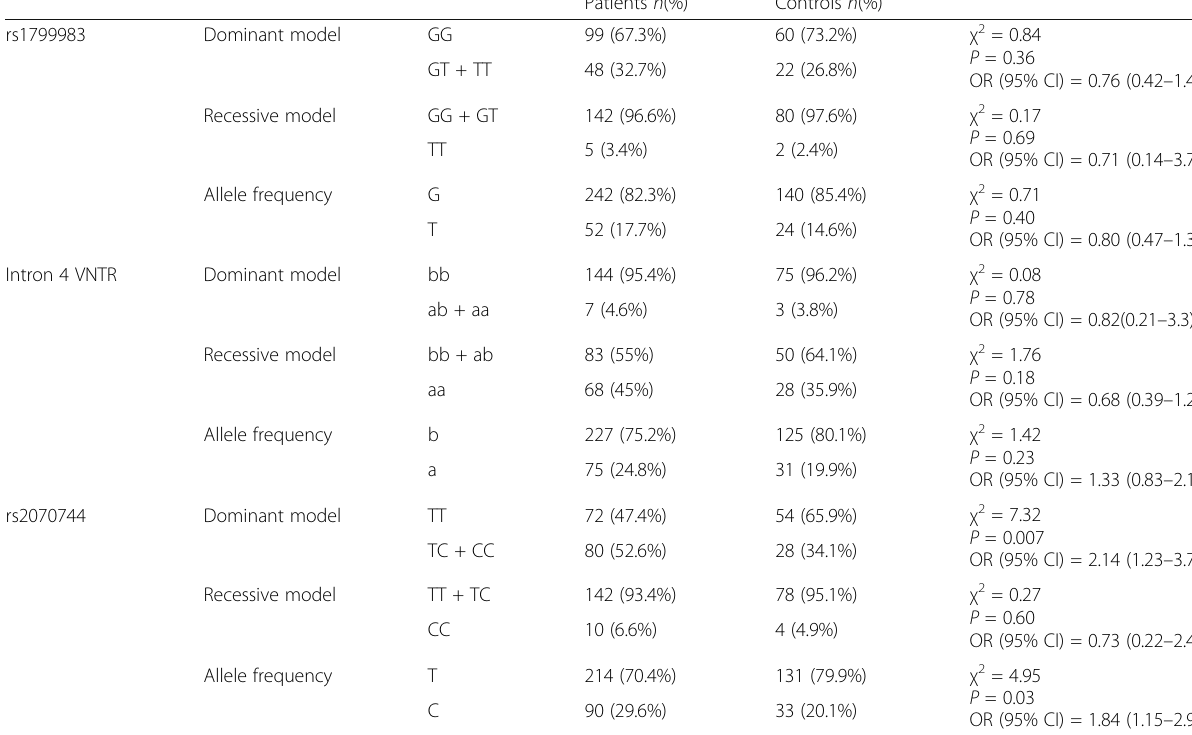
Table 4 Genotype distribution under dominant and recessive models and allele frequencies of the rs1799983, Intron 4 VNTR and rs2070744 in patients and control groups